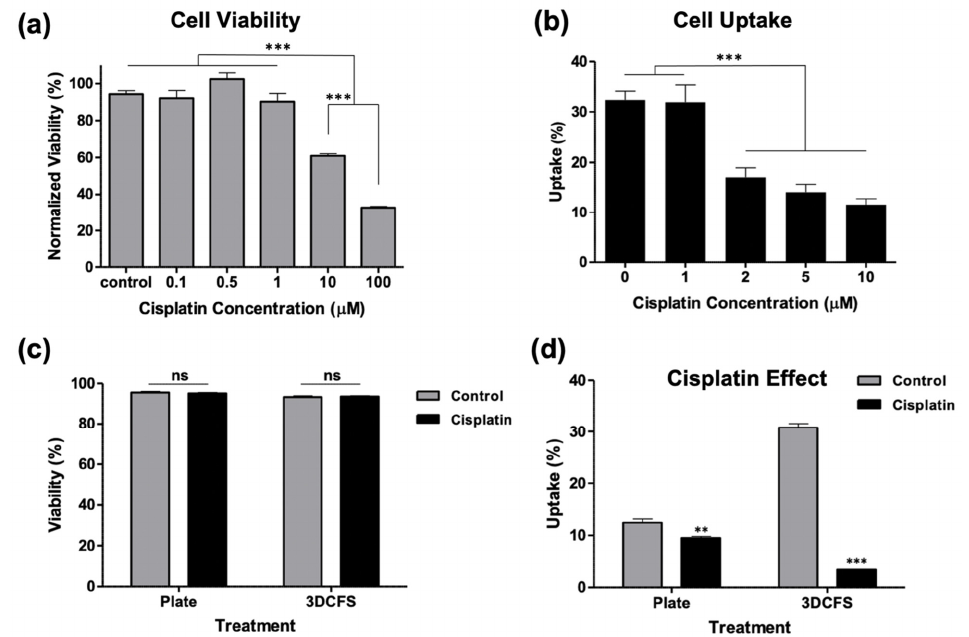
Figure 6. Biochemical manipulation of A375 cells’ mechanics using cisplatin treatment. The A375 cells’ actin structure was reinforced by treating the cells with cisplatin. ( a ) The cells were incubated in 96-well plate for 24 h using different concentration of cisplatin and their viability was measured using WST-1 assay to test which concentration could be used without affecting the cells’ viability. ( b ) The cells were incubated with particles for 4 h in 96-well plate after treatment with different cisplatin concentrations for 6 h. Particle uptake was significantly decreased starting from 2 µM. ( c–d ) Cells were treated with 2 µM cisplatin for 6 h and incubated for an additional 4 h both in static and floating conditions and were measured for c cells viability and ( d ) particle uptake. p -value: *** ≤ 0.001, ** ≤ 0.01.